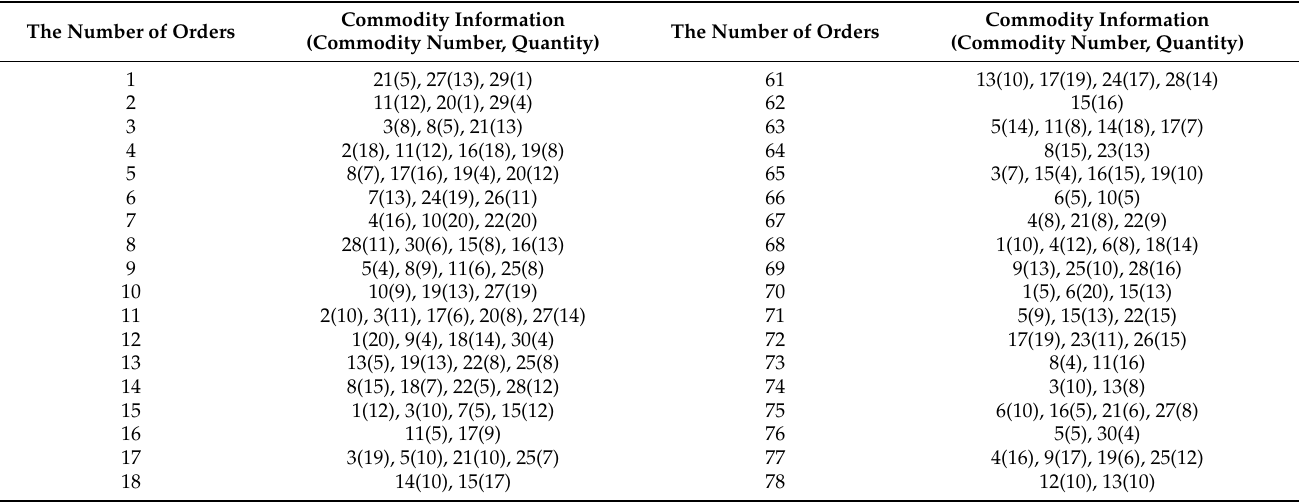
Table A3. Symbol description of model static picking order to determine the target